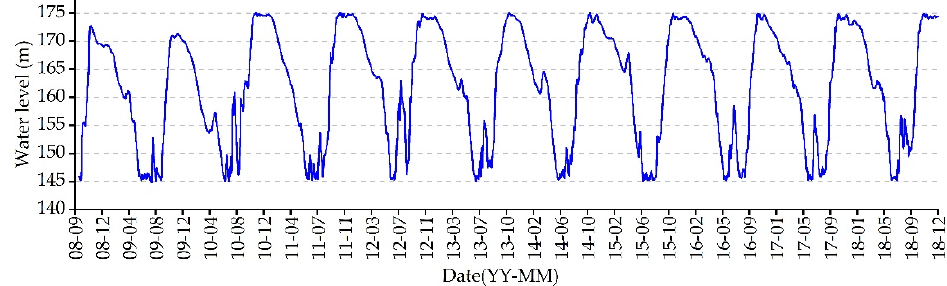
Figure 2. Water level variation in the Three Gorges Reservoir during 2008 and 2018.